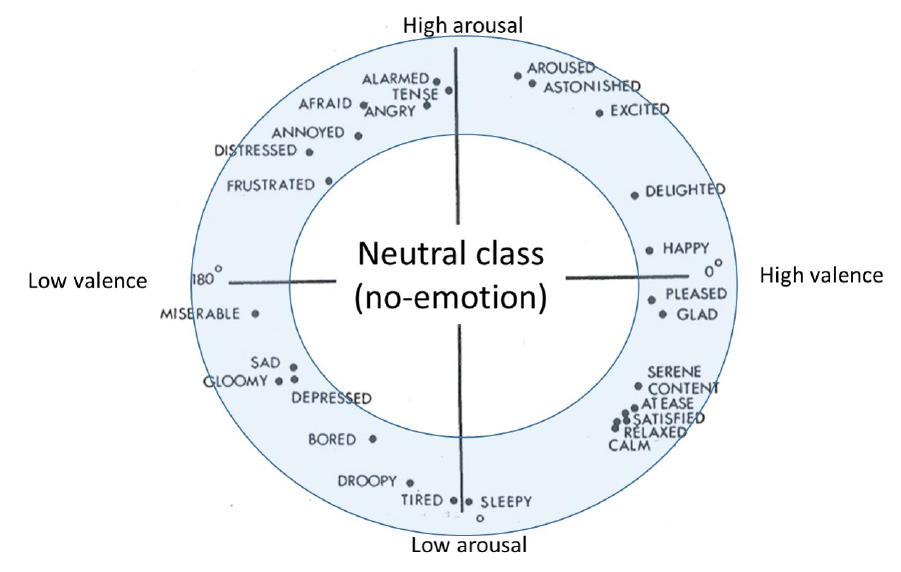
Figure 3. The circumplex model for emotion description that shows the arrangement of the emotional states around the circumference of the 2D arousal-valence plane